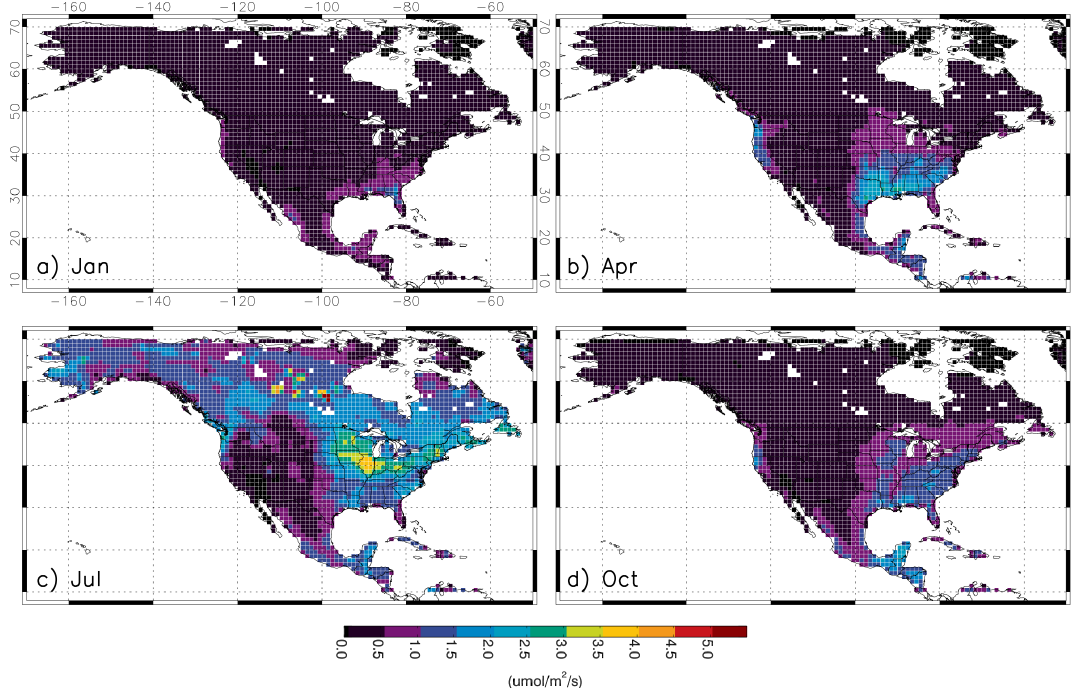
Figure 6. A posteriori weekly flux uncertainty during (a) January, (b) April, (c) July, and (d) October, for case 1 (1.57µm and 0.5ppm RRV error). Shown here are RMS values from the first 4 weeks of each month. 1µmolm − 2 s − 1 = 1 . 037gCm − 2 d − 1 = 4 . 4 × 10 − 8 kgCO 2 m − 2 s − 1